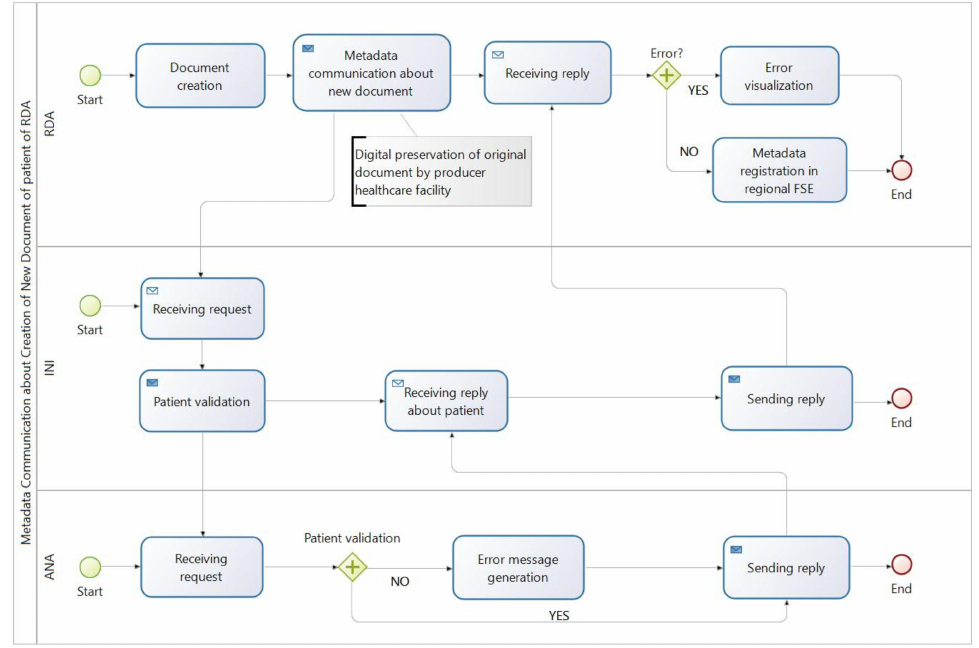
Figure 2. Metadata communication process about the creation of a new document for a patient in the